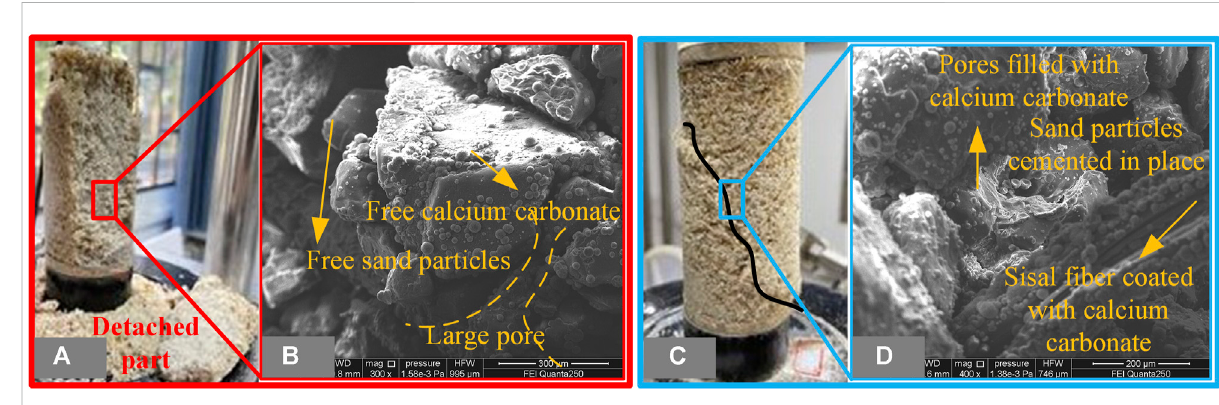
FIGURE 8 FailurecrackofEICP-treated sandwithout fi ber: (A) macroscopicimage; (B) microscopicimages.FailurecrackofEICP-treatedsandreinforced with sisal fi bers: (C) macroscopic image; (D) microscopic